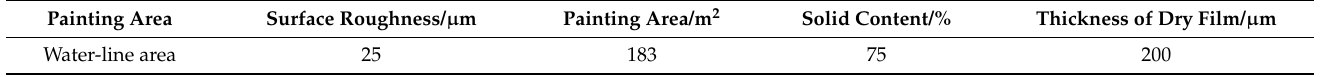
Table 5. Feature value of the object to be painted.